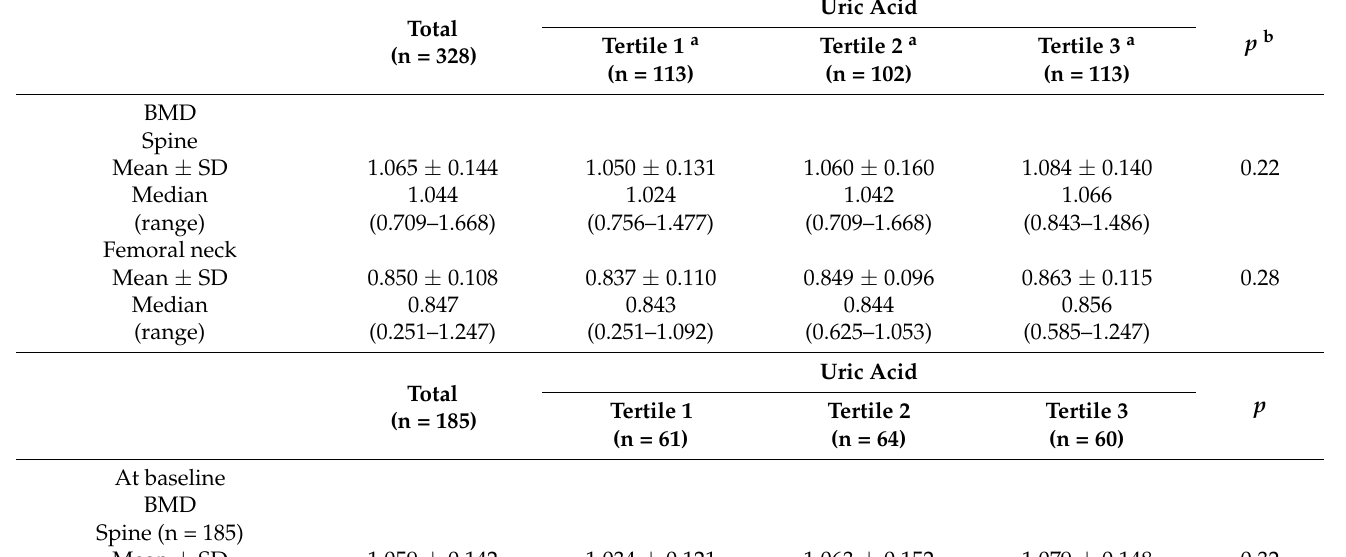
Table 2. Distribution of BMD according to the serum uric acid level at baseline (n = 328) and follow-up (n =